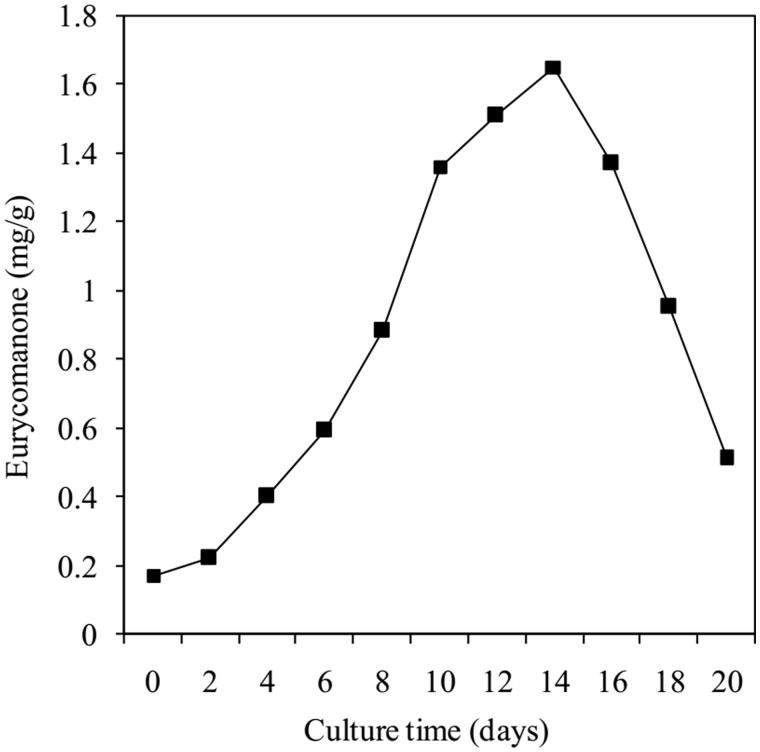
Time course of eurycomanone accumulation in E. longifolia cells.